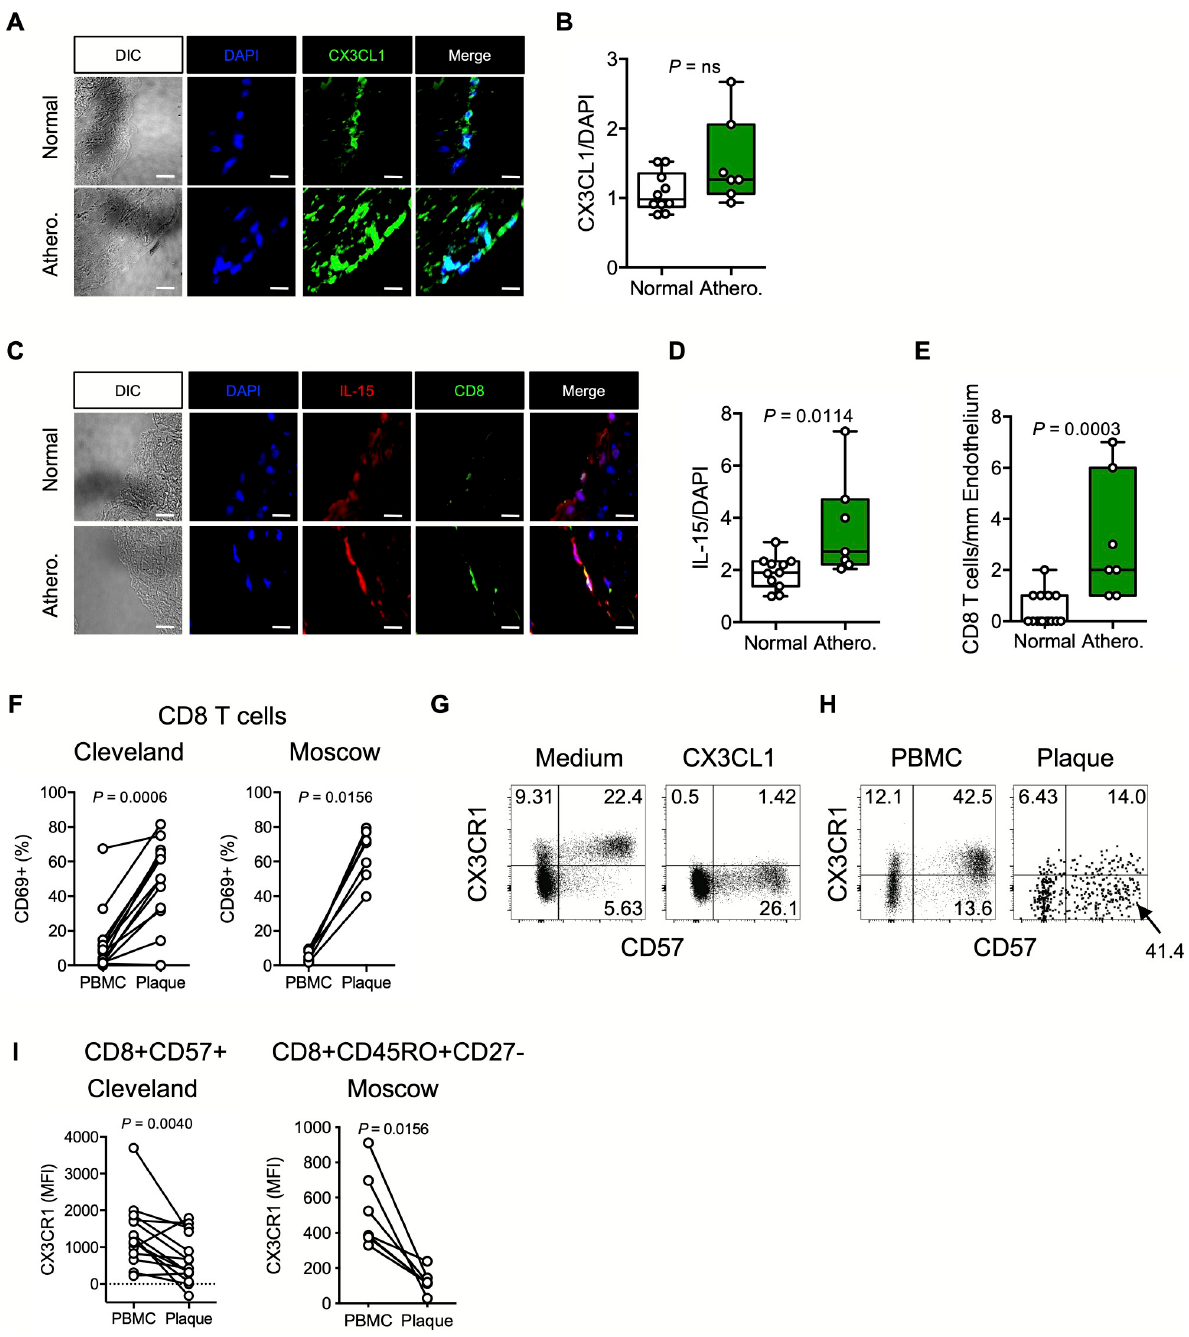
Fig 2. Expression of CX3CL1 and IL-15 in human atherosclerotic plaque tissue in proximity to CD8 T cells. (A) Endothelial DAPI and CX3CL1 expression in artery sections from normal donors (n = 10, top) and from donors with atherosclerosis (n = 7, bottom). (B) Ratio of CX3CL1 fluorescence to DAPI fluorescence per section. (C) Endothelial DAPI and IL-15 expression in artery sections from normal donors (n = 10, top) and from donors with atherosclerosis (n = 7, bottom). (D) Ratio of IL-15 fluorescence to DAPI fluorescence per section. (E) Number of CD8 T cells per mm endothelium within sections from normal donors (n = 15) and from donors with atherosclerosis (n = 7). Differences between groups were determined by Mann-Whitney U test. (F) Proportion of CD8 T cells that express CD69 in PBMCs or donor-matched plaque tissues from donors from Cleveland, Ohio, USA (n = 13) and Moscow, Russia (n = 7). (G) Representative dotplots (n = 2) showing surface expression of CX3CR1 and CD57 on peripheral blood CD8 T cells following overnight exposure to CX3CL1 or medium control. (H) Representative dotplots (n = 13) showing surface CX3CR1 and CD57 expression on CD8 T cells derived from the plaque and peripheral blood. (I) Surface CX3CR1 MFI on CD57+ CD8 T cells from donors from Cleveland, Ohio, USA (n = 13, left) and on effector memory (CD45RO+CD27-) CD8 T cells within PBMCs or donor-